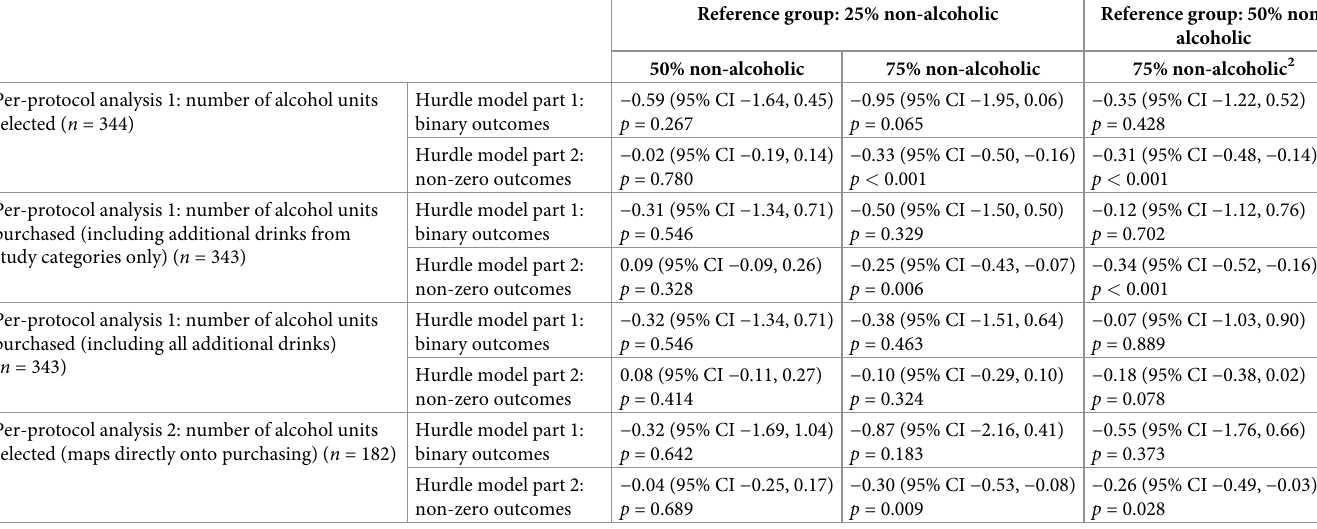
Table 5. Per-protocol analyses for participants that purchased drinks: model estimates (95% confidence intervals), p -values 1